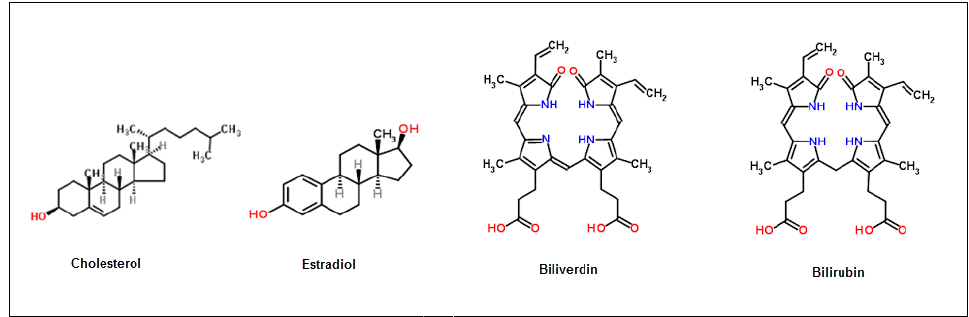
Scheme 1. Molecular structures of cholesterol, estradiol, biliverdin and